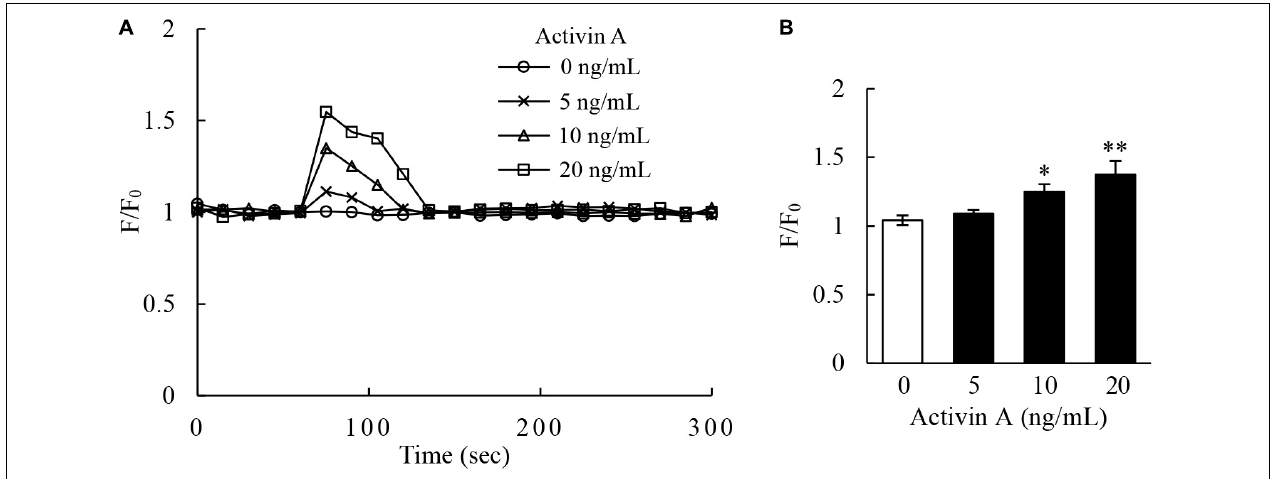
FIGURE 5 | Effect of activin A on calcium signaling of L929 cells. (A) Kinetics of calcium signal was measured by the Fluo-4 intensity in L929 cells treated with 0–20 ng/mL activin A. (B) The graph showed the peak values of calcium signal upon stimulation under different concentrations activin A. The calcium level was represented by the Fluo-4 signal intensity normalized to the baseline (F/F 0 ). The graph represented the results from three separate experiments. ∗ P < 0.05 and ∗∗ P < 0.01 compared with 0 ng/mL control